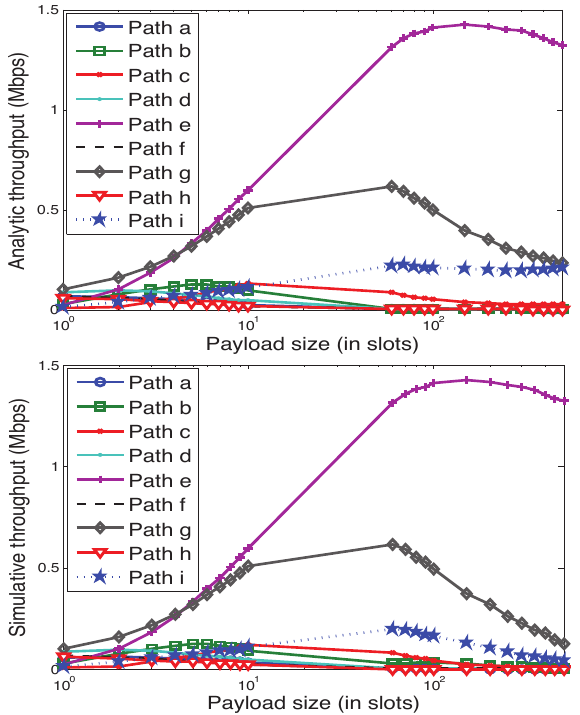
Figure 7. Average end-to-end throughput from model versus simulation when varying the payload size.